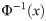
Significance testing in association studies.The null distribution is the standard normal distribution and the expected distribution of the association statistics under the assumption that the effect size is 0. Each variant’s association statistic in Eq 2 is computed, and its significance is evaluated using the null distribution. If the statistic falls in the significance region of the distribution, the variant is declared associated. In this example, S1 is not significant, whereas S2 and S3 are significant. The exact location of the threshold is defined as the location on the x-axis where the tail probability area equals the significance threshold (S). This is denoted using the quantile of the standard normal Φ-1x.